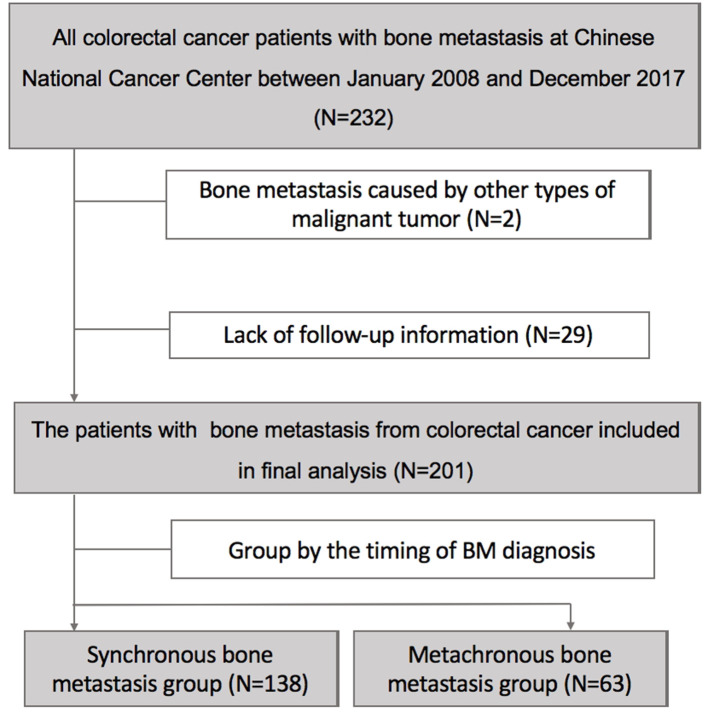
The analytical cohort and exclusion criteria.